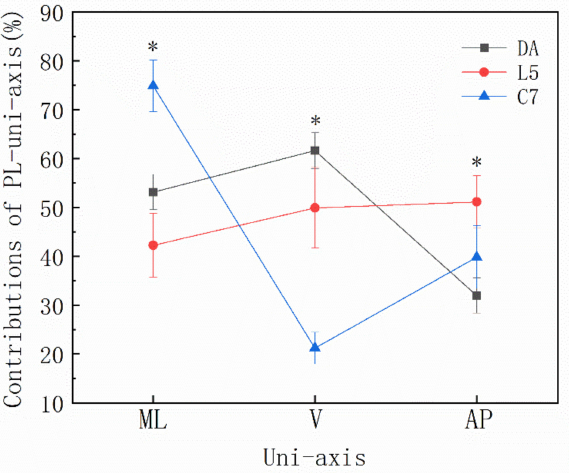
Figure 6. The different uniaxial contributions to the total PlayerLoad responses for the dominant ankle (DA), the fifth lumbar vertebra (L5) and the seventh cervical vertebra (C7) for the Zapateado-3 footwork in three planes: medial-lateral (ML), vertical (V) and anterior-posterior (AP). * Denotes a significant main effect for the